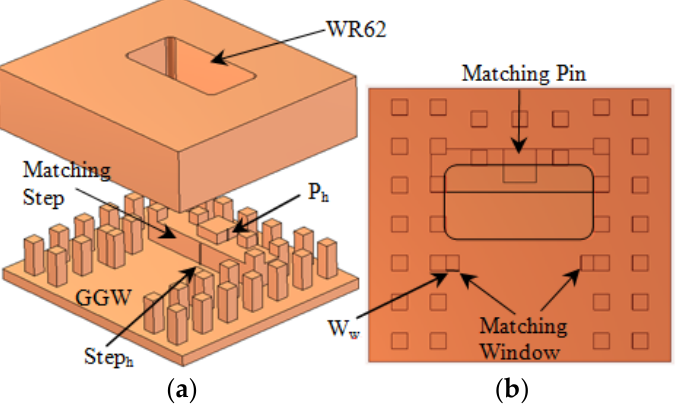
Figure 1. ( a ) Periodic pin structure, ( b ) groove gap waveguide structure, and ( c ) the dispersion diagram of the pins. The parameters are h = 4.5 mm, w = 1.65 mm, d = 4.1 mm, ag = 0.1 mm, and G w = 15.8 mm.